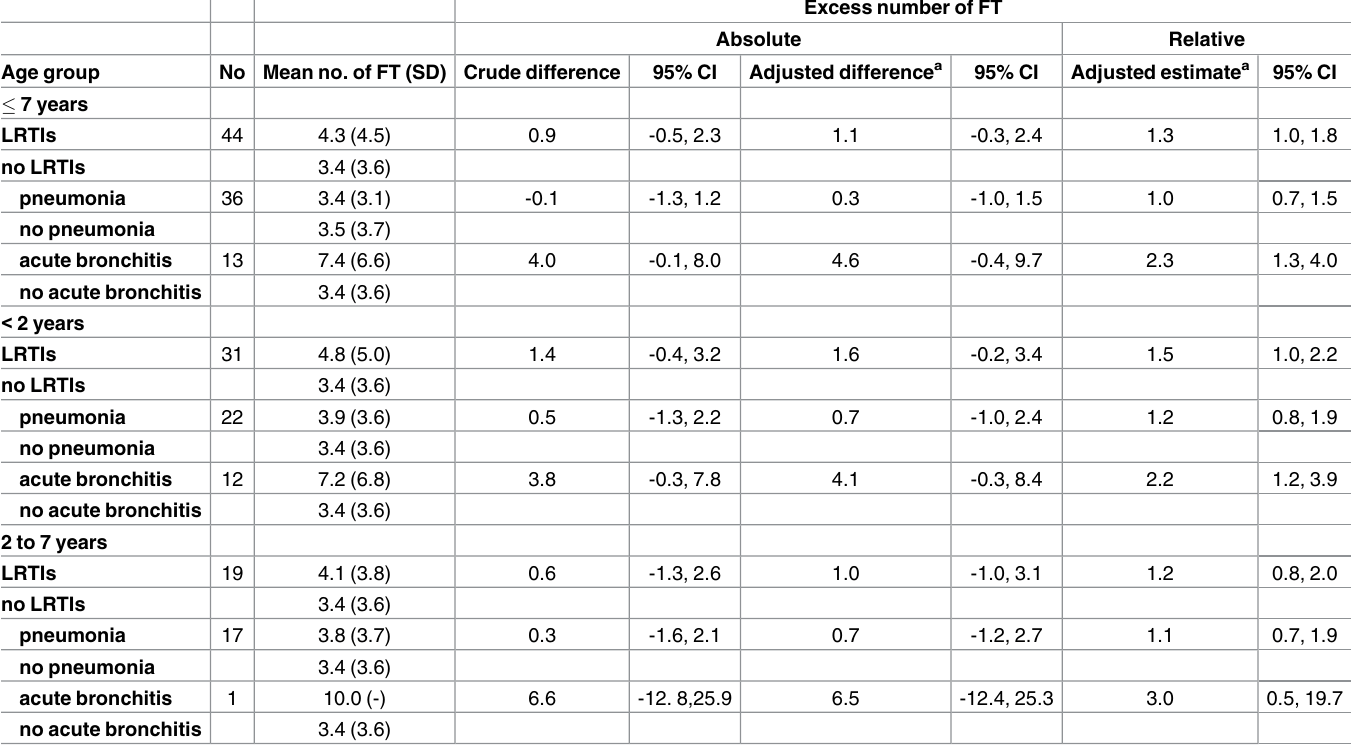
CI, confidence interval; FT, filled teeth; LRTI, lower respiratory tract infection; No, number a Adjusted for sex, age, family socioeconomic status, secondhand smoke exposure from birth to age 3 years, preterm birth and the occurrence of LRTIs later/before the time period under